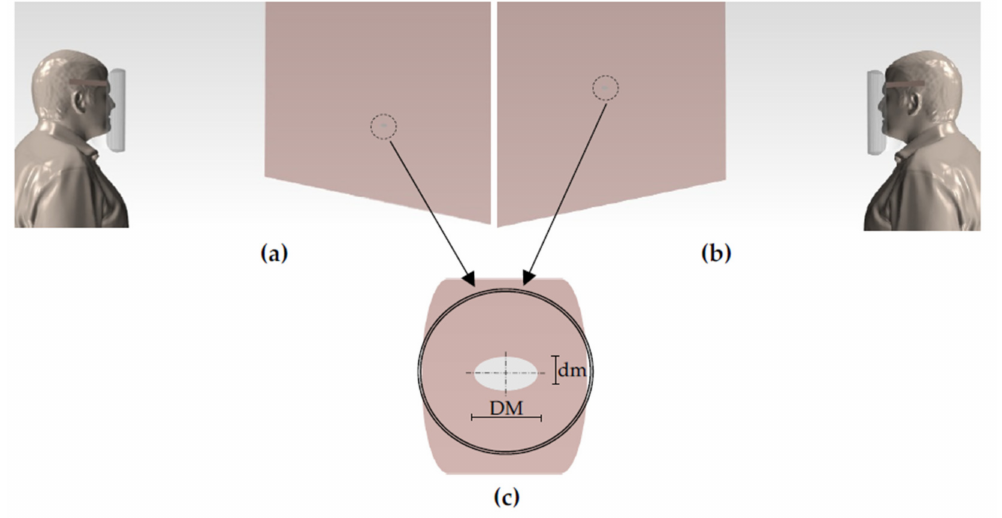
Figure 4. Position of the mouth at 1.5 m: ( a ) The same height as the human with the face shield, 1.6 m; ( b ) A difference of height of 20 cm; ( c ) Geometry of the mouth (DM = 40 mm and dm = 20 mm) to simulate a sneeze.